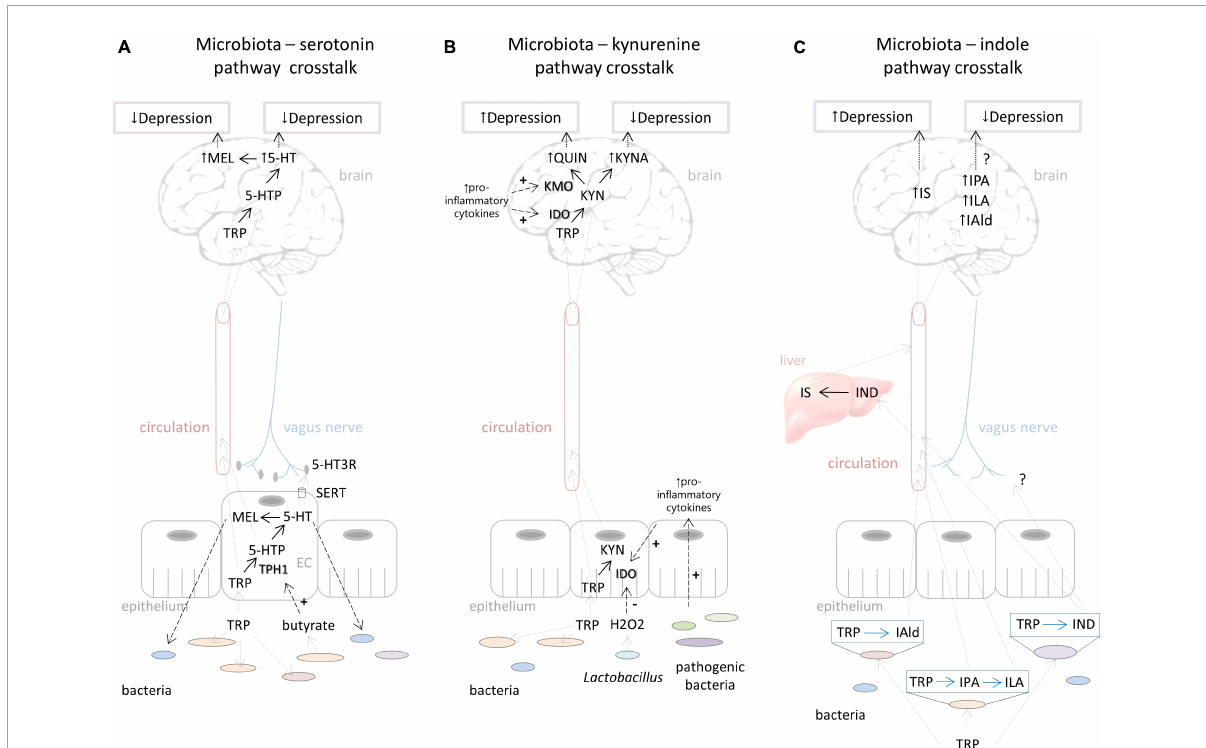
FIGURE2 Putative ways of gut microbiota – host interactions in the context of the tryptophan metabolism influencing depressive behavior. (A) Effects of microbiota on serotonin pathway include regulation of tryptophan availability which directly influences serotonin and probably melatonin synthesis in the brain affecting depressed mood. Microbiota can stimulate TPH1 activity by its metabolites (e.g., butyrate). Serotonin produced in the gut could have an impact on brain functioning via stimulation of the vagus nerve. On the other hand, host serotonin and melatonin synthesis in the gut can affect the commensal bacterial composition, contributing individual’s susceptibility to depression. (B) Bacterial effects on the kynurenine pathway include down-regulation of IDO activity by H 2 O 2 produced by Lactobacillus . The proliferation of pathogenic bacteria that stimulates pro-inflammatory cytokine production stimulates IDO activity and QUIN branch of the kynurenine pathway. Increased QUIN is associated with depression. On the other hand, increased KYNA levels could be related to reduction of depressive symptoms. (C) Depending on the specific catalytic enzymes that different bacterial species harbor, tryptophan can be degraded into various indolic compounds. They are absorbed by the host into the circulation and can be further metabolized in lever; for example, indole is metabolized to IS, which could, in high concentrations, lead to depressive behavior. Various indolic compounds (e.g., IPA, ILA, IAld) were shown to have neuroprotective effects, but their effects on depression are still unexplored. For more details, see explanations in the text. Black dashed arrows represent directions of effects (“+” - represents stimulation, “-” - represents inhibition). Gray dashed arrows represent directions of movement of metabolites. Black dotted arrows represent effects on depression. Black full arrows represent host pathways. Blue full arrows represent bacterial pathways. Question marks represent effects that are not still well explored. TRP, tryptophan; TPH, tryptophan hydroxylase; 5-HTP, 5-hydroxytryptophan; 5-HT, 5-hydroxytryptamine (serotonin); MEL, melatonin; SERT, serotonin transporter; EC, enterochromaffin cells; IDO, indolamine 2,3-dioxygenase; TDO, tryptophan 2,3-dioxygenase; KYN, kynurenine; KYNA, kynurenine acid; KMO, kynurenine 3-monooxygenase; QUIN, quinolinic acid; IAld, indole-3-aldehyde; IPA, indole-3-propionic acid; ILA, indole-3-lactic acid; IND, indole; IS,